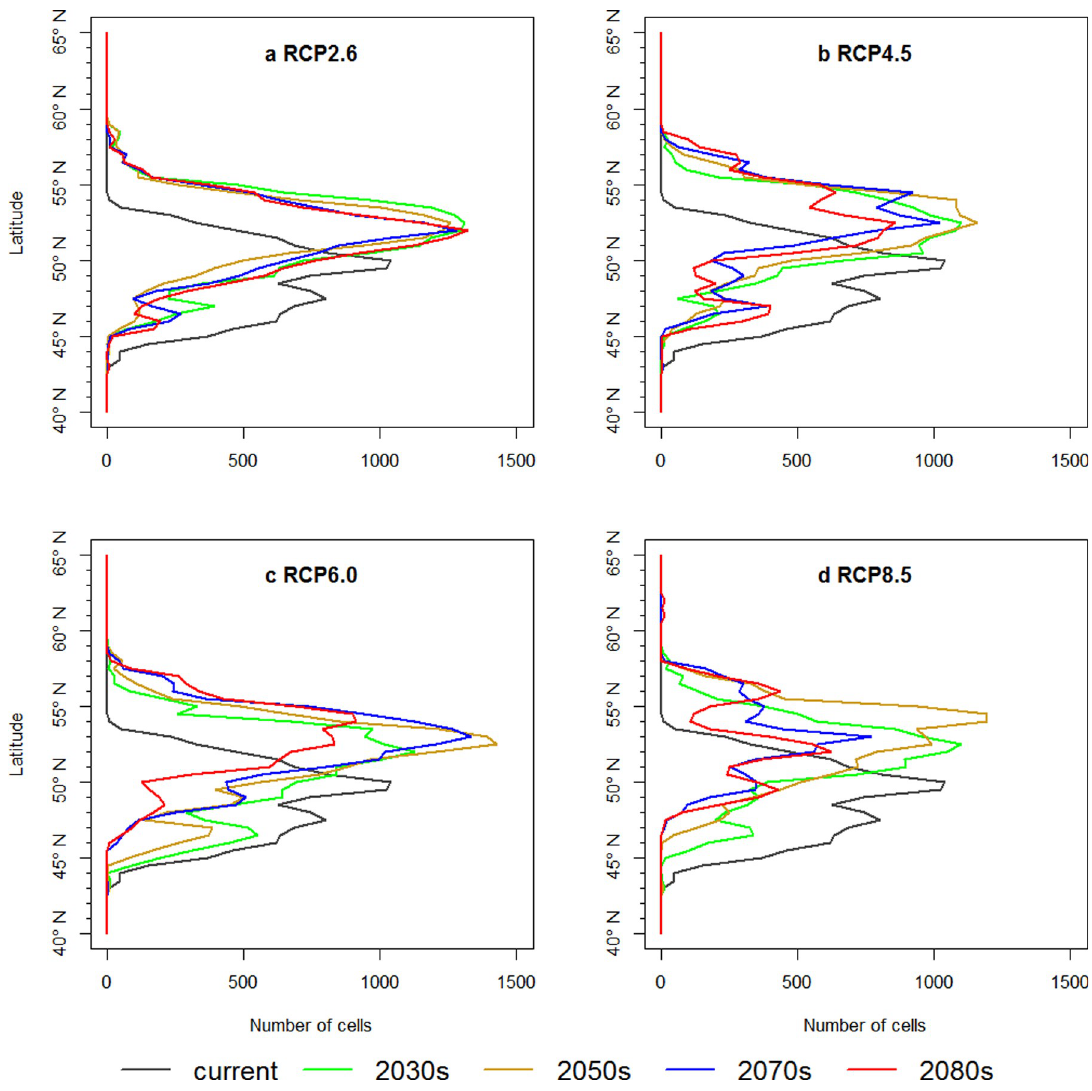
Fig 2. Latitudinal pattern of predicted breeding range area (Bandwidth = 0.5